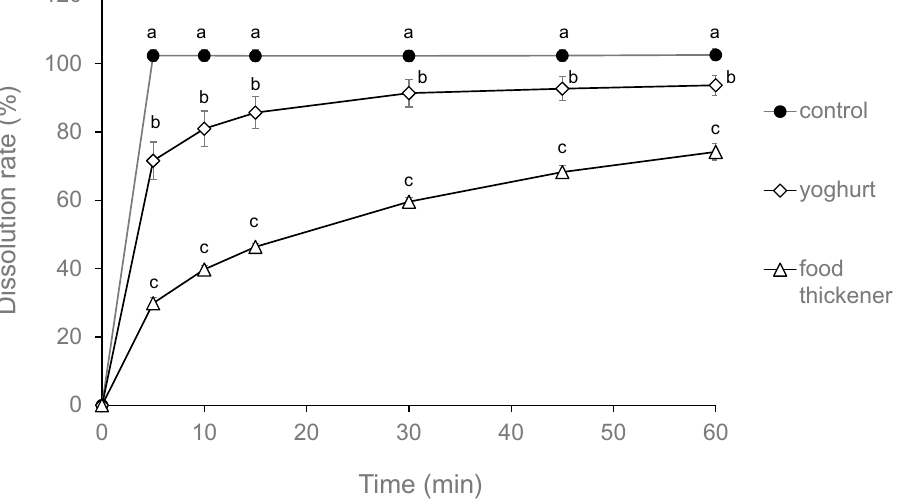
Figure 1. Famotidine powder dissolution rates after mixing with swallowing aid foods. Dissolution rates were measured at 0, 5, 10, 15, 30, 45, and 60 min. Control: only famotidine powder; Yoghurt: famotidine powder mixed with yoghurt; Food thickener: famotidine powder mixed with food thickener. Data are expressed as means ± SD for five samples. Different letters at each time indicate statistically significant differences, determined using one-way ANOVA and Tukey’s post-hoc